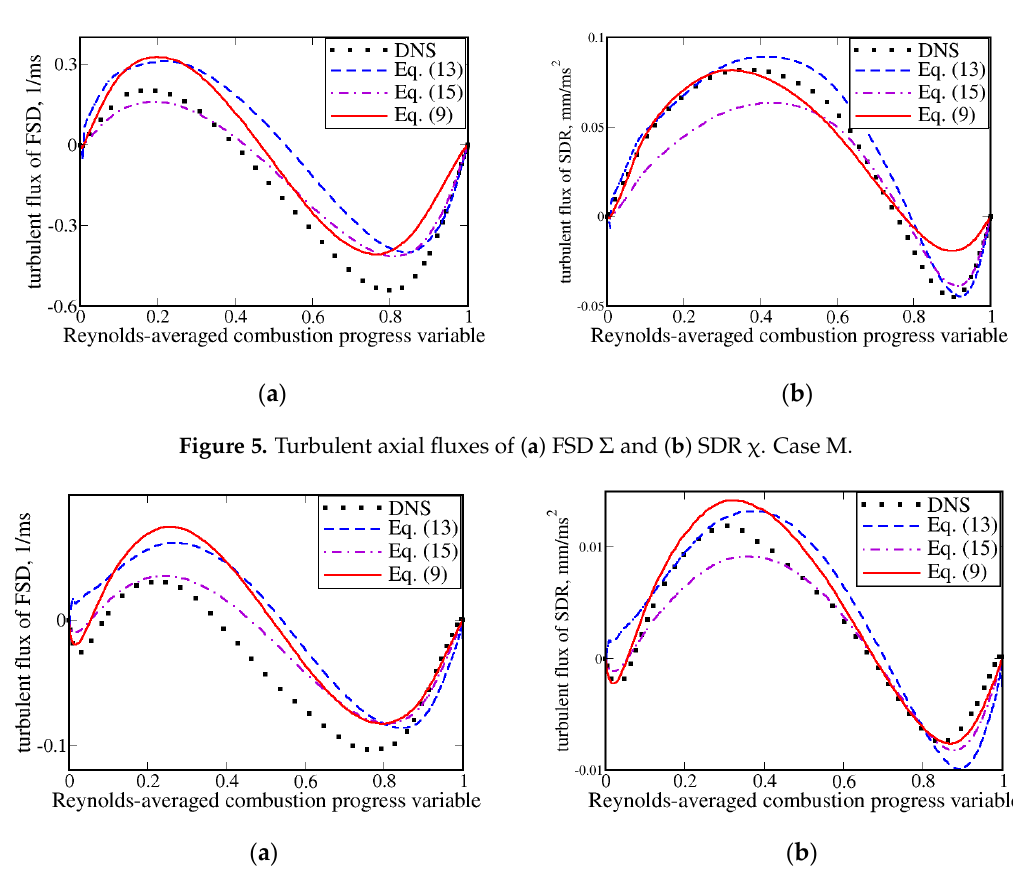
Figure 4. Turbulent axial fluxes of ( a ) FSD Σ and ( b ) SDR χ . Case H.